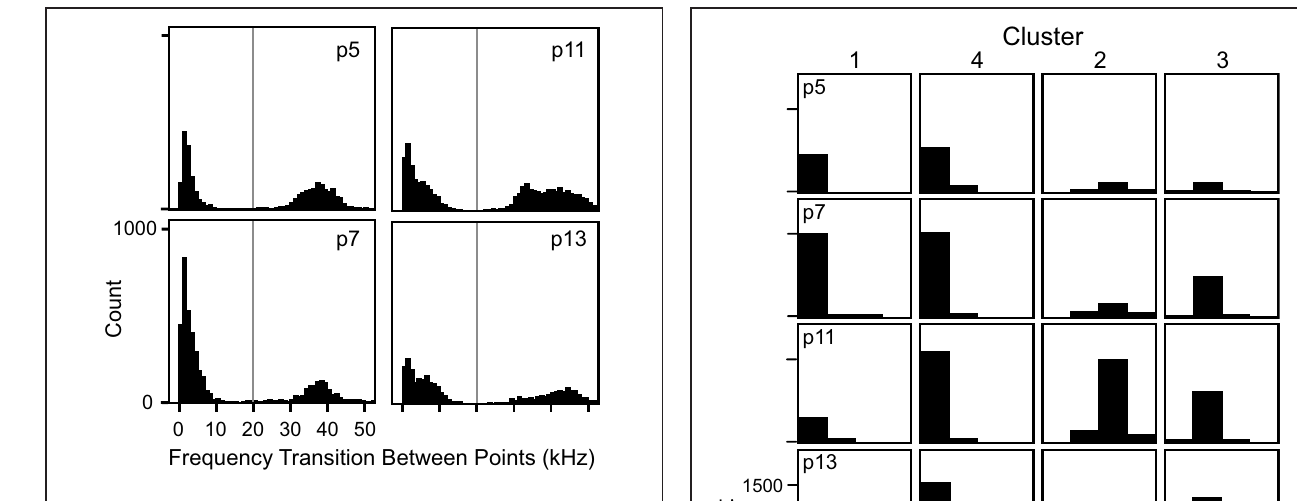
The majority of syllables in c3 had only 1 frequency step. The